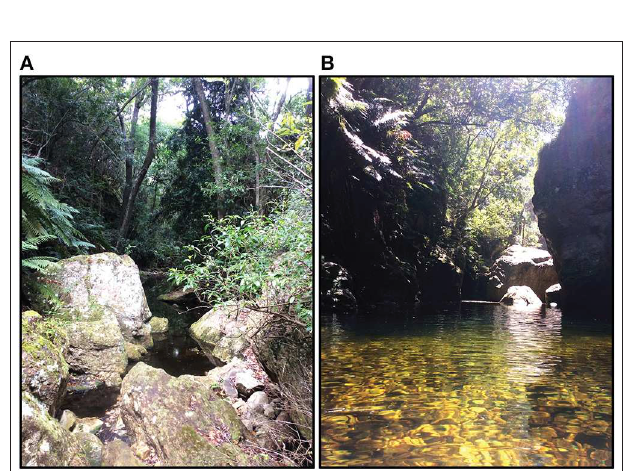
FIGURE 2 | Headwater tributaries in the Swartkops River watershed. Example of: (A) no trail through the rugged terrain and thick forest typical across sites; (B) steep overhanging cliffs framing the tributary requiring wading and swimming across the pool to access upstream sites.